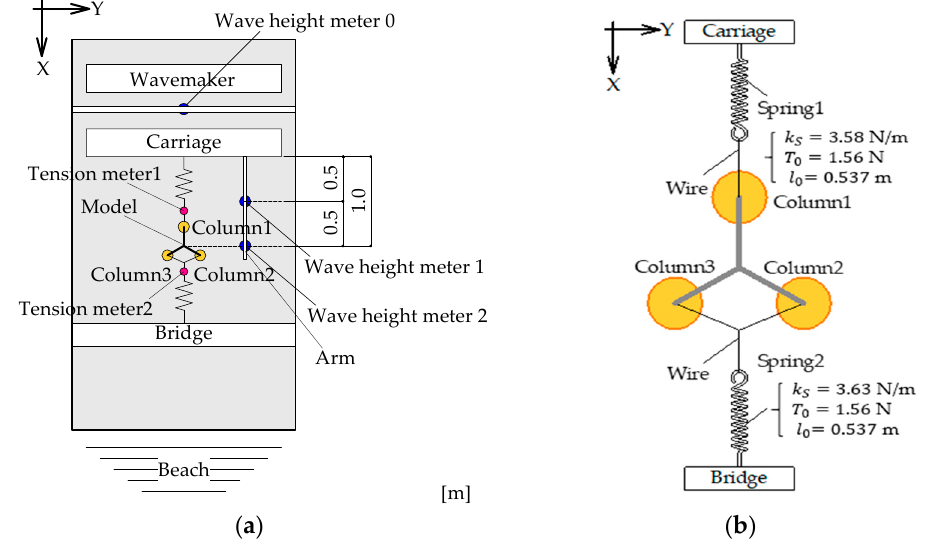
Figure 3. Experimental setup: ( a ) top view of the experimental setup in the towing tank; ( b ) details of the top view of the mooring line settings.